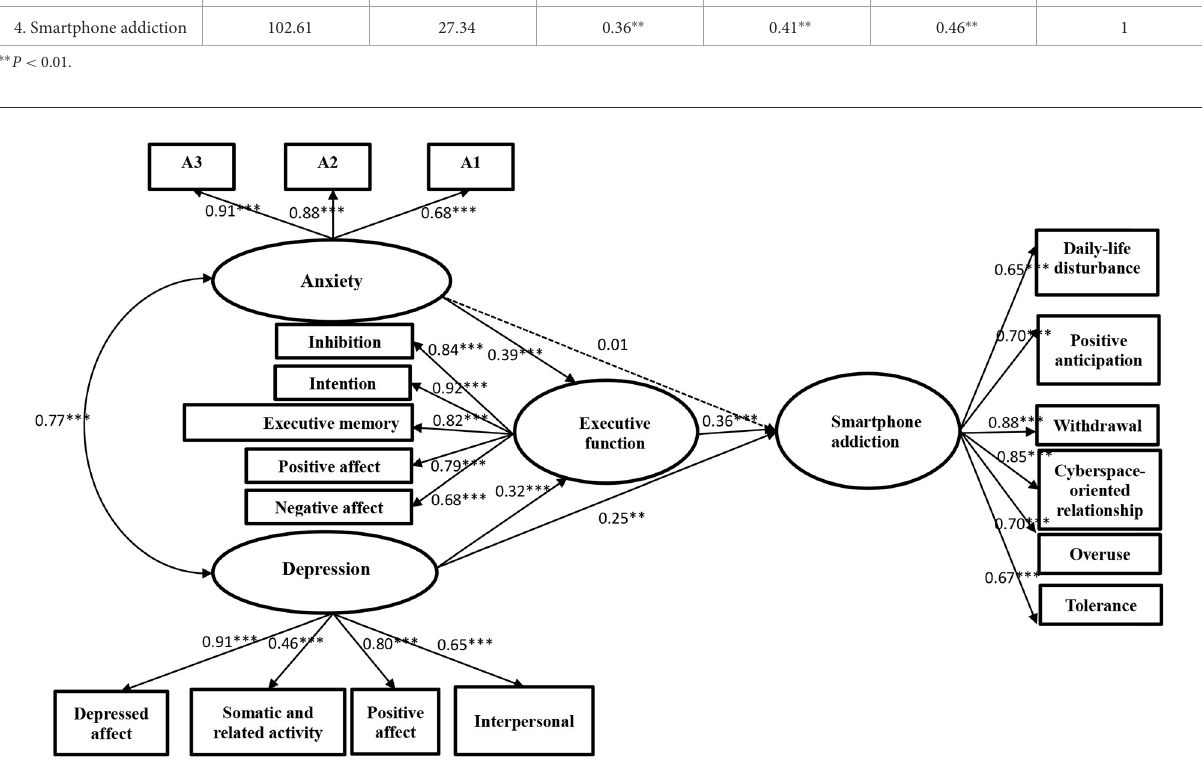
FIGURE2 Final model concerning the mediation effect of executive dysfunction in the relationships between anxiety and depression with smartphone addiction. * P < 0.05, ** P < 0.01, *** P <